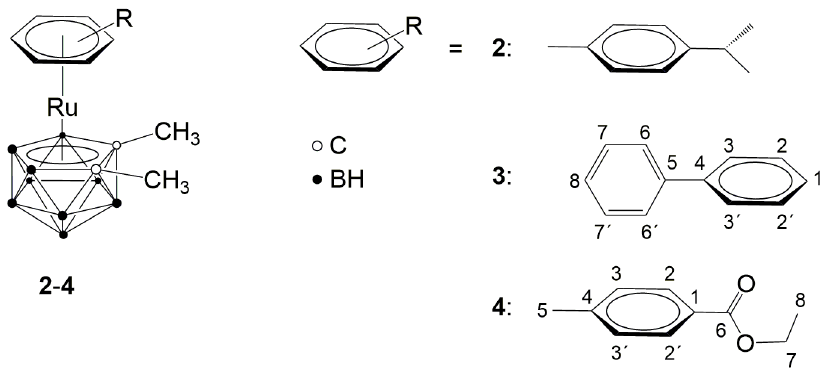
Figure 2. Structure of complexes 2 to 4